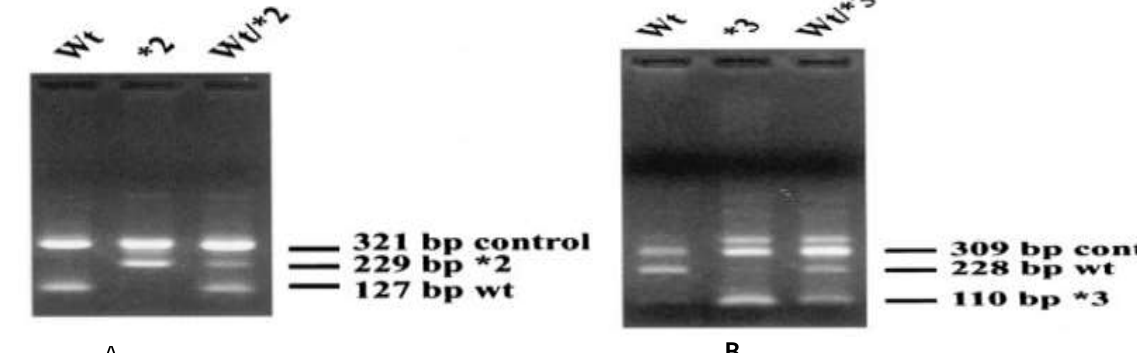
Figure1. Polymerase chain reaction and tetra ARMS pattern of (A):CYP2C19*2 (681 G>A) Polymorphism and (B):CYP2C19*3 (636 G>A) Polymorphism. ARMS=Amplification- Refractory -Mutation-System. PCR = Polymerase Chain Reaction. Wt. - Wild type, bp- base pair.